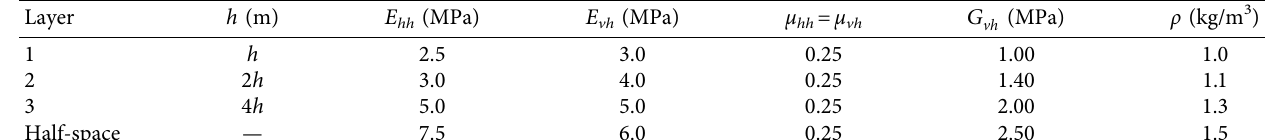
Table 1: Te material parameters of the crossanisotropic layered medium.